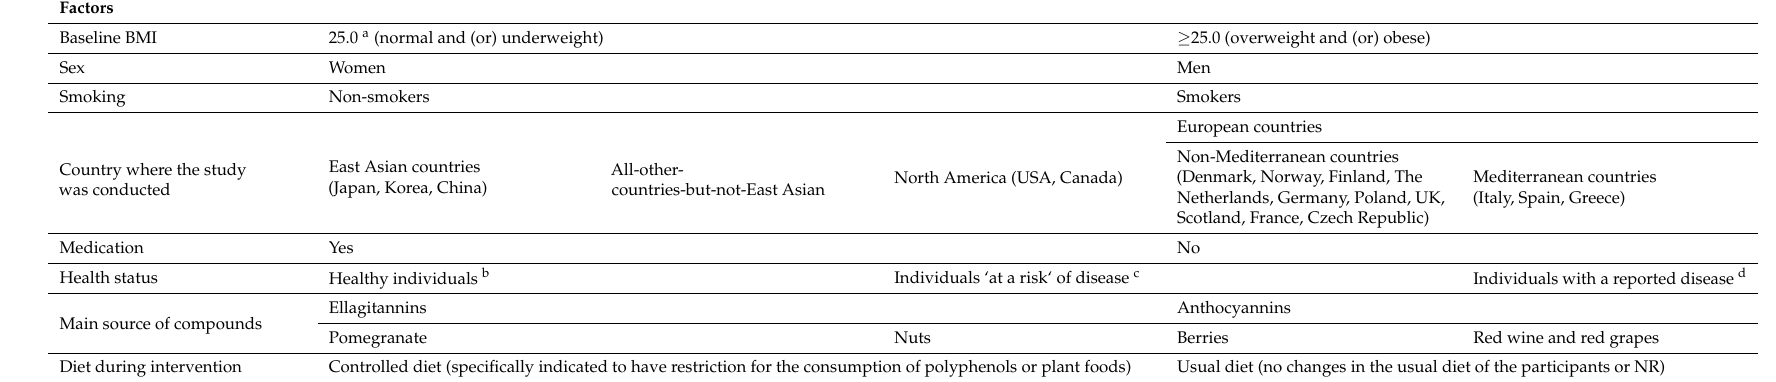
Table 5. Potential factors influencing the heterogeneity in the responses to the supplementation with ellagitannins and/or anthocyanins-containing products investigated in this